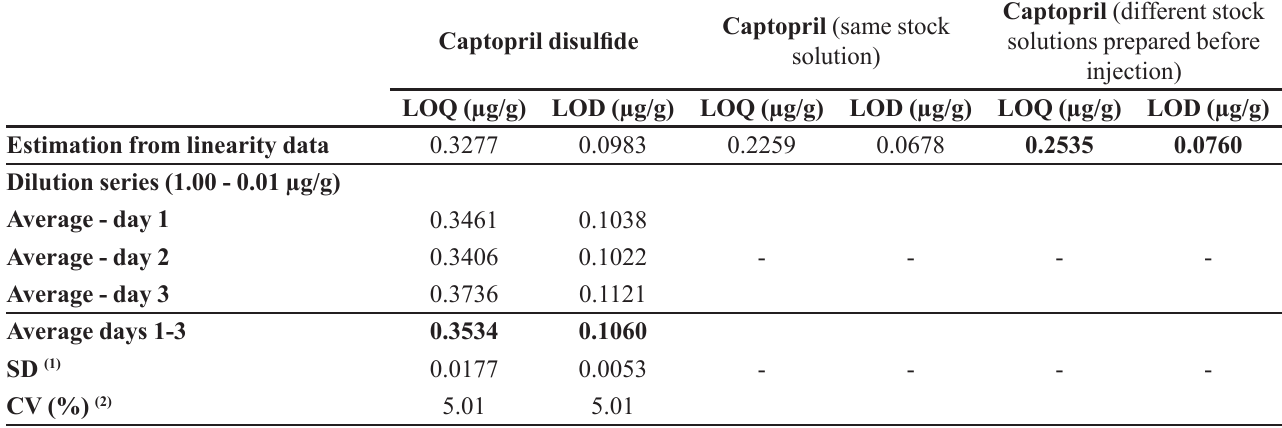
TABLE III - Determination of limit of quantitation (LOQ) and limit of detection (LOD) for captopril disulfide and